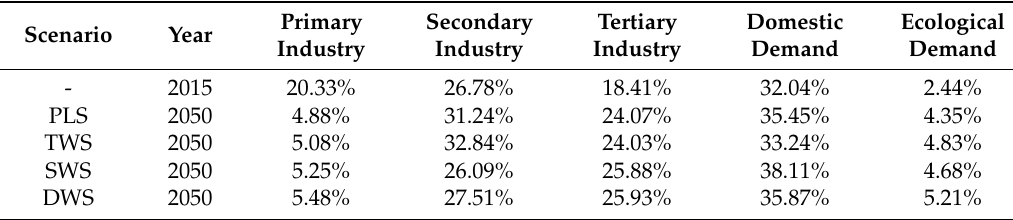
Figure 3. Water demand in Xiamen City under different scenarios. Note: PLS is the acronym for planning scenario; TWS is the acronym for technical water-saving scenario; SWS is the acronym for structural water-saving scenario; DWS is the acronym for double water-saving scenario. Table 4. The proportion of water used in each industry.